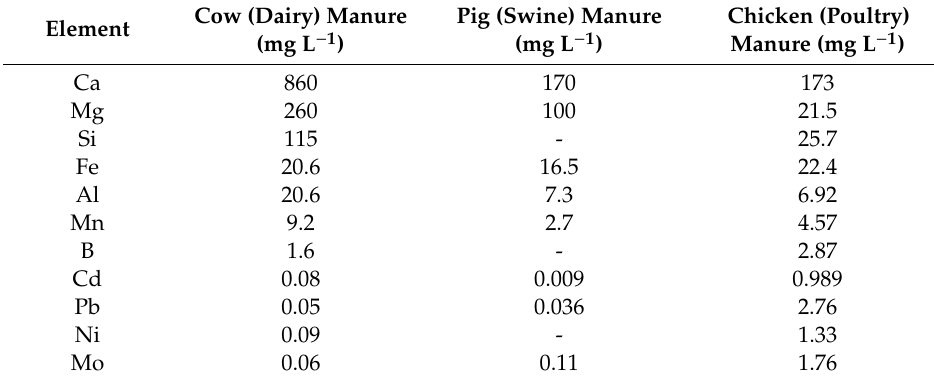
Table 2. Elemental composition of cow (dairy) manure, pig (swine) manure and chicken (poultry) manure presented in di ff erent reports (source: for dairy manure, [23]; for swine manure, [9]; and for poultry manure